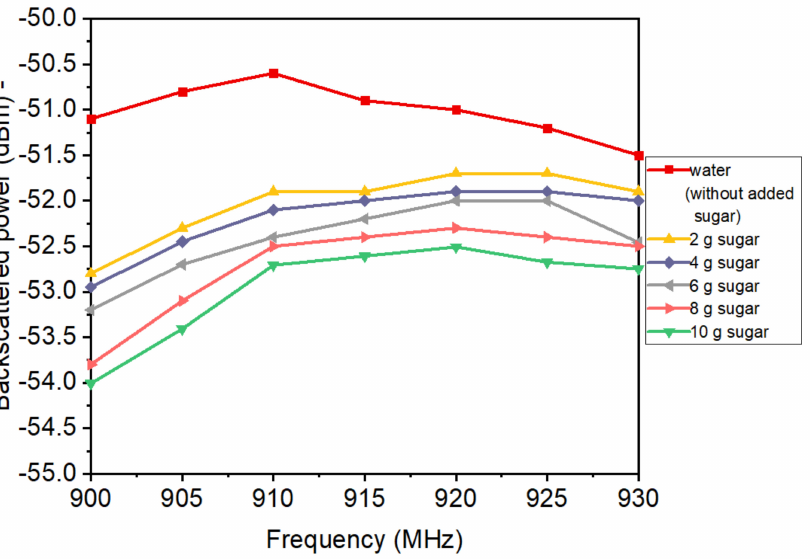
Figure 5. Measured RSSI using Tagformance setup with different quantities of sugar as a